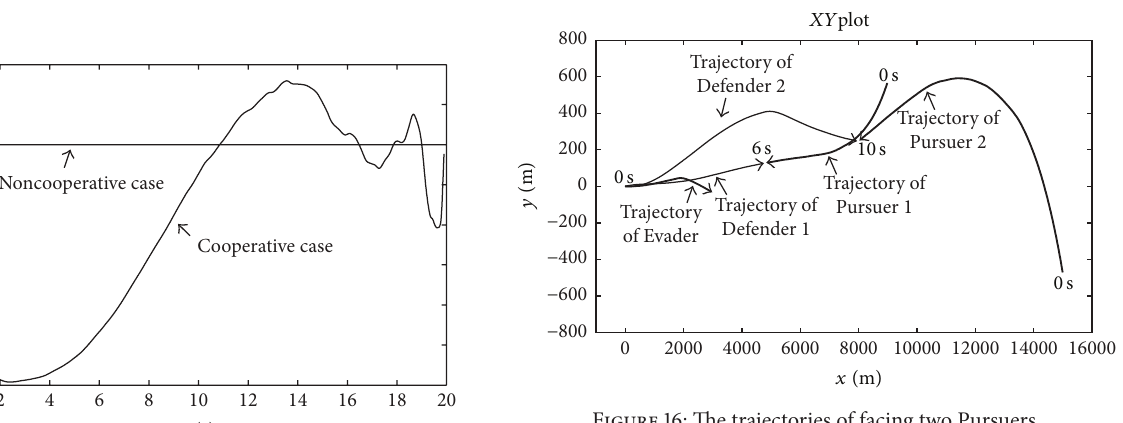
Figure 13: The Defender acceleration considering HP guidance Pursuer.